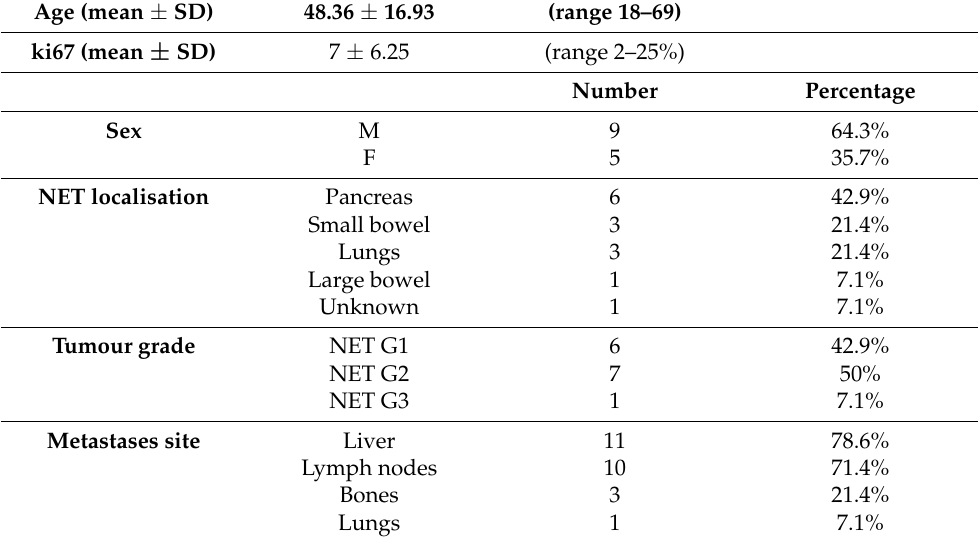
Table 1. Patient